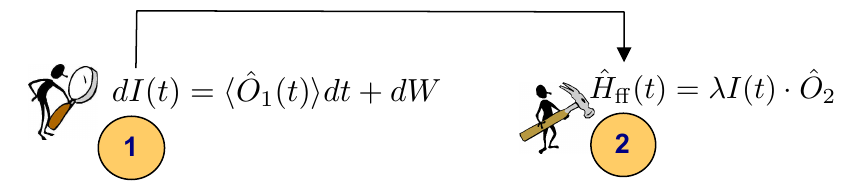
Figure 8: Schematic of a generic measurement plus feedforward scheme. The observ- able ˆ O of system 1 is continuously monitored, with the results of the measurement 1 (encoded in the measurement record I ( t ) used to drive system 2 via the operator ˆ O . The unconditional evolution under this scheme results in a purely directional 2 interaction between the two systems. In the limit where delay in applying the feed- forward force can be ignored, the resulting evolution corresponds to our general non-reciprocal master equation (with the proviso that both coupling operators must be